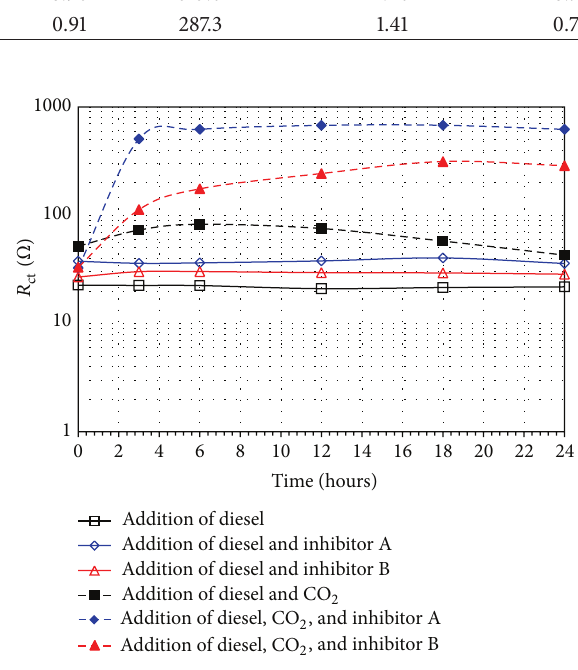
Figure 7: 𝑅 variation for each simulated experimental ct